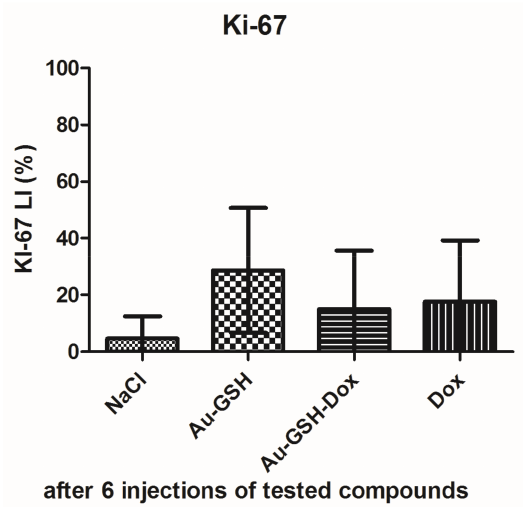
Figure 14. Statistical analysis of Ki-67 LI in FISS after six intratumoral injections of test compounds. Data are presented as the mean with